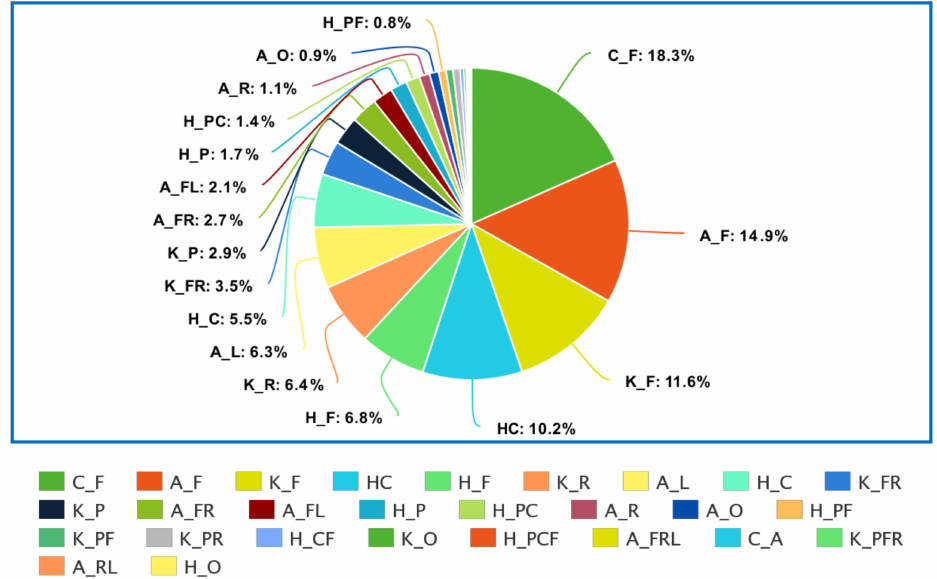
Figure 2. Imbalanced distribution of classes in the target variable.